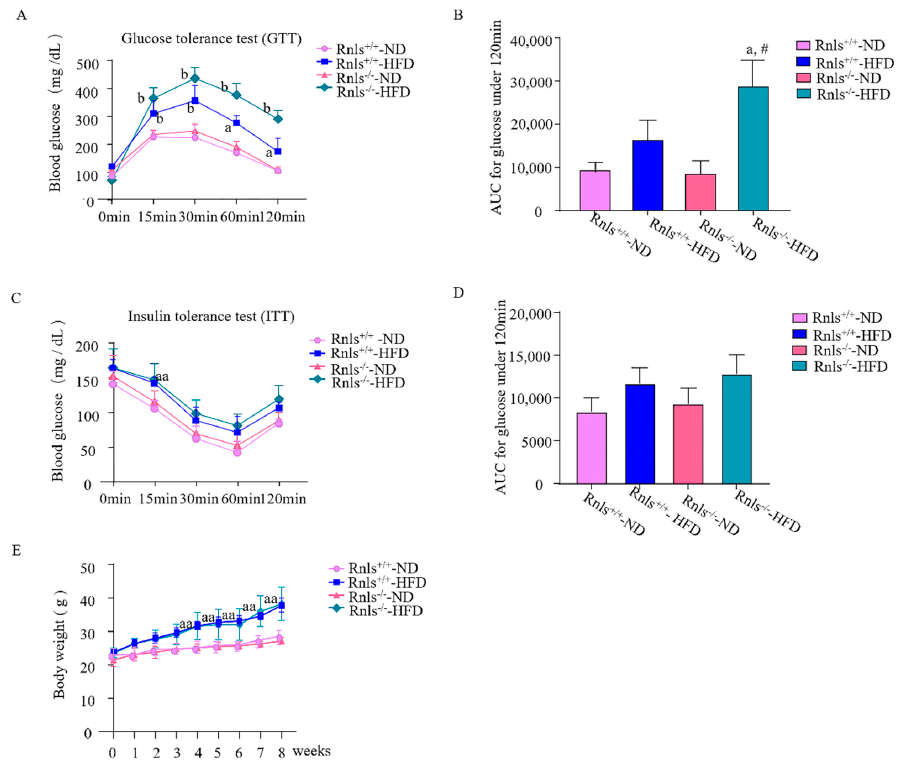
Figure 2. Phenotype of mice with or without Rnls and food intervention. ( A ) IPGTT, ( B ) AUC for IPGTT, ( C ) IPITT, ( D ) AUC for IPITT, ( E ) body weight. Values are presented as mean ± standard derivation; n = 5 per group. Data are predicted through two-way ANOVA (Tukey’s post hoc test) with repeated measures. a: p < 0.05, b: p < 0.01, indicating significant differences among diverse mouse groups compared with the Rnls +/+ -ND group under the same timeline (time point or weeks). #: p < 0.05, indicating a significant difference compared with the Rnls +/+ -HFD group. Rnls –/– -ND, renalase gene knockout mice fed with normal diet; Rnls +/+ -ND, wild-type mice fed with normal diet; Rnls –/– -HFD, renalase gene knockout mice fed with high-fat diet; Rnls +/+ -HFD, wild-type mice fed with high-fat diet; AUC, area under the curve; IPITT, intraperitoneal insulin tolerance test; IPGTT, intraperitoneal glucose tolerance test; ANOVA, analysis of variance. 3.2. Individual Taxa Richness and Evenness of Microbiota in Rnls +/+ and Rnls -/- Mice We used α diversity measures to identify within-individual taxa richness and even- ness. The stable species rarefaction curve showed that sampling size (sequencing depth) data were large enough to reflect the majority of microbial diversity information in the sample and met the requirements for data analysis (Figure 3A). Shannon, Chao1, and Faith-pd indices indicated no significant difference in microbiota community diversity between the four groups (Figure 3B–D).